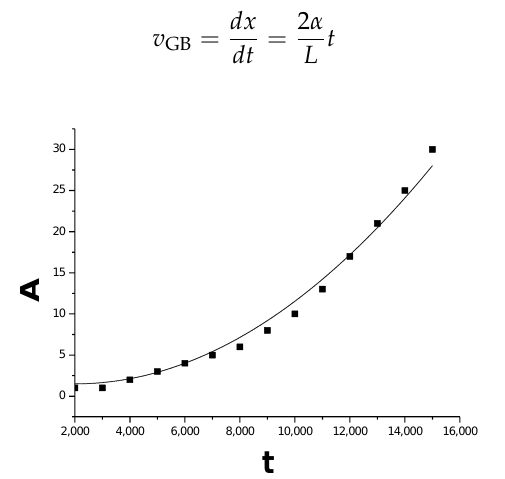
Figure 9. Growth curve of the area A of the deformed grain vs time t by the PFC simulation.